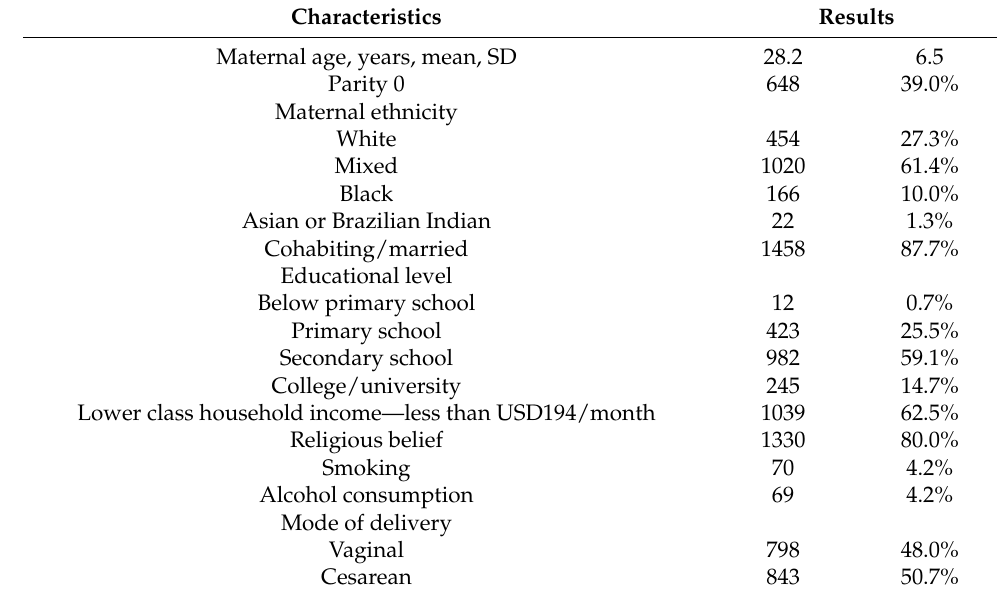
Table 1. Characteristics, perinatal outcomes and maternal anxiety assessed by the Beck Anxiety Inventory (BAI) at the end of pregnancy during the Coronavirus disease (COVID-19) outbreak